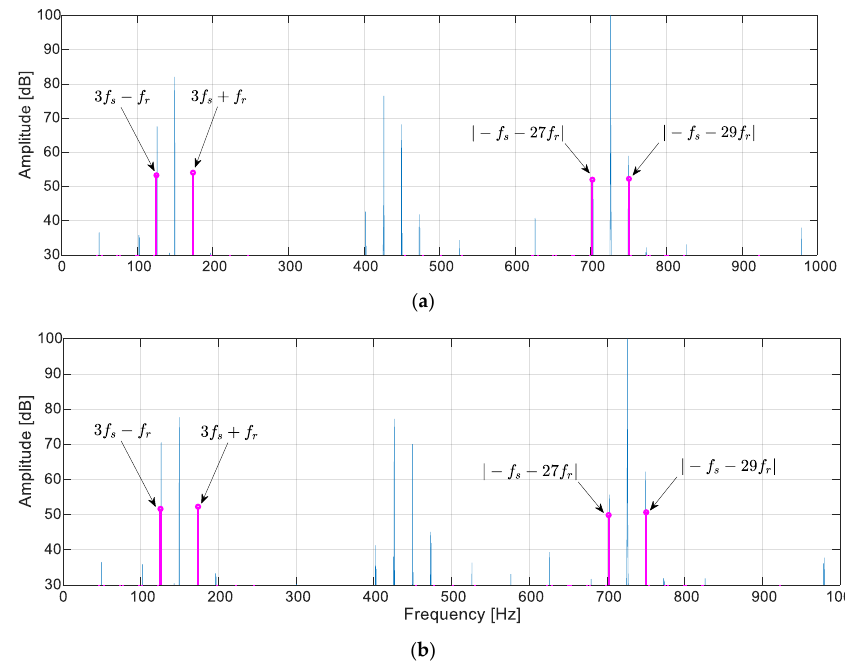
Figure 11. ZSC spectrum of motor with mixed eccentricity for the stator winding connections: ( a ) delta connection; ( b ) wye connection with neutral wire.